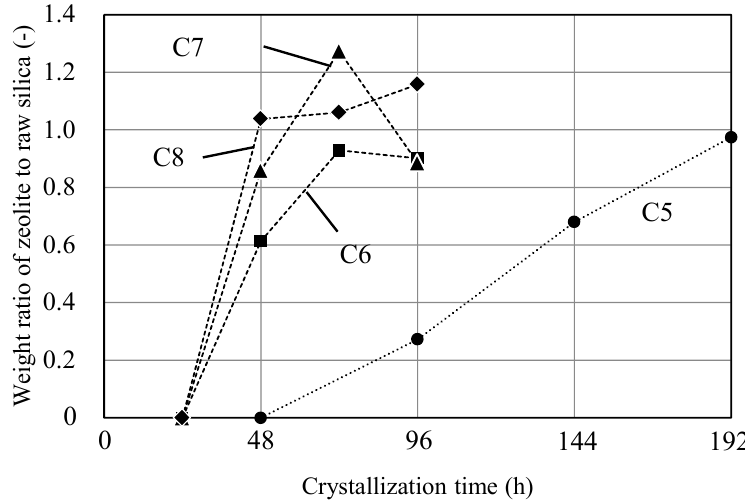
Figure 4. Weight ratio of zeolite to raw silica for gel compositions C5–C8 at 413 K.